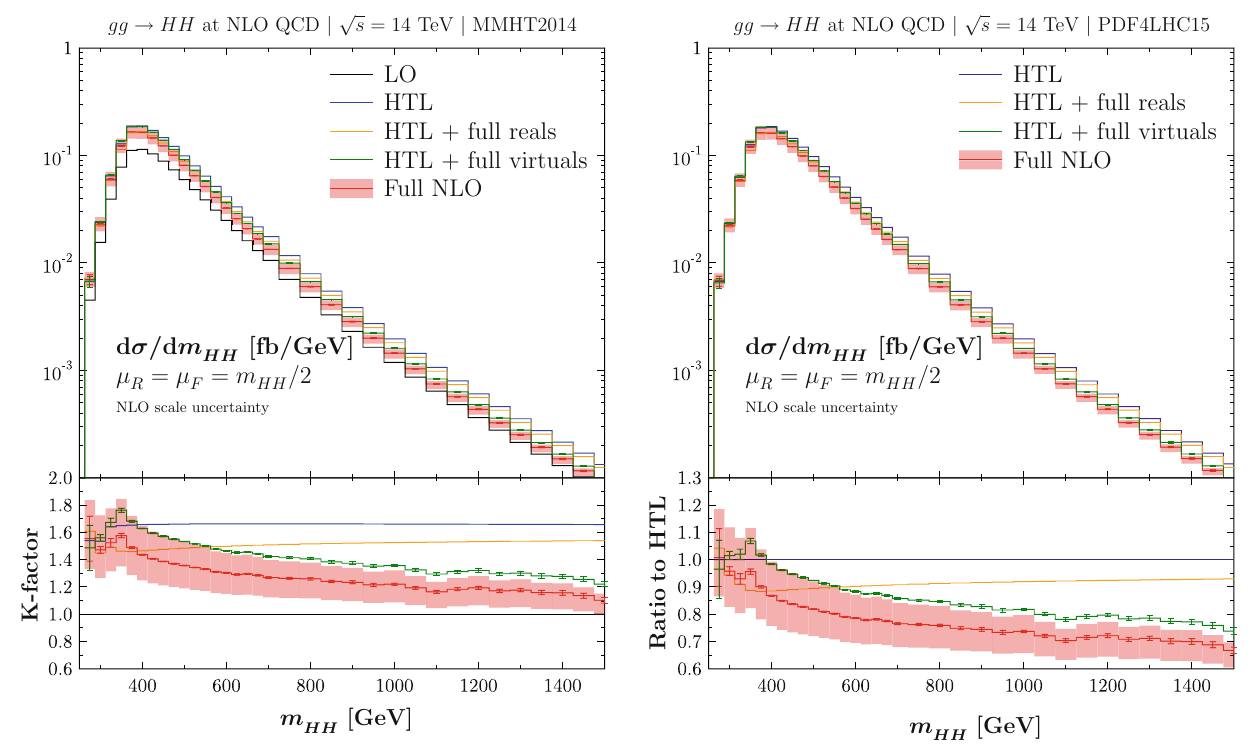
Fig. 2 Invariant Higgs-pair-mass distributions for Higgs boson pair production via gluon fusion at the 14 TeV LHC as a function of Q = m HH . LO results (in black), HTL results (in blue), HTL results including the full real corrections (in yellow), HTL results including the full virtual corrections (in green, including the numerical error), and the full NLO QCD results (in red, including the numerical error).